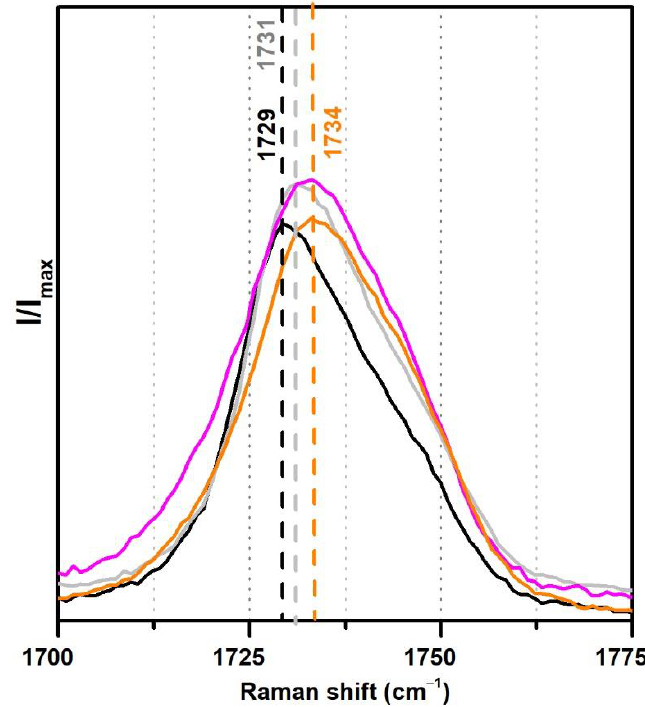
Figure 8. Raman spectra of the pure PVAc emulsion (black), PVAc stabilised with 10% PVAl (grey), Polidisp DM21 (pink), Polidisp DM23 (orange) between 1700 and 1775 cm − 1 . According to technical data sheets, these Polidisp commercial formulations are composed of P(VAc-VeoVa) stabilised with polymeric compounds.